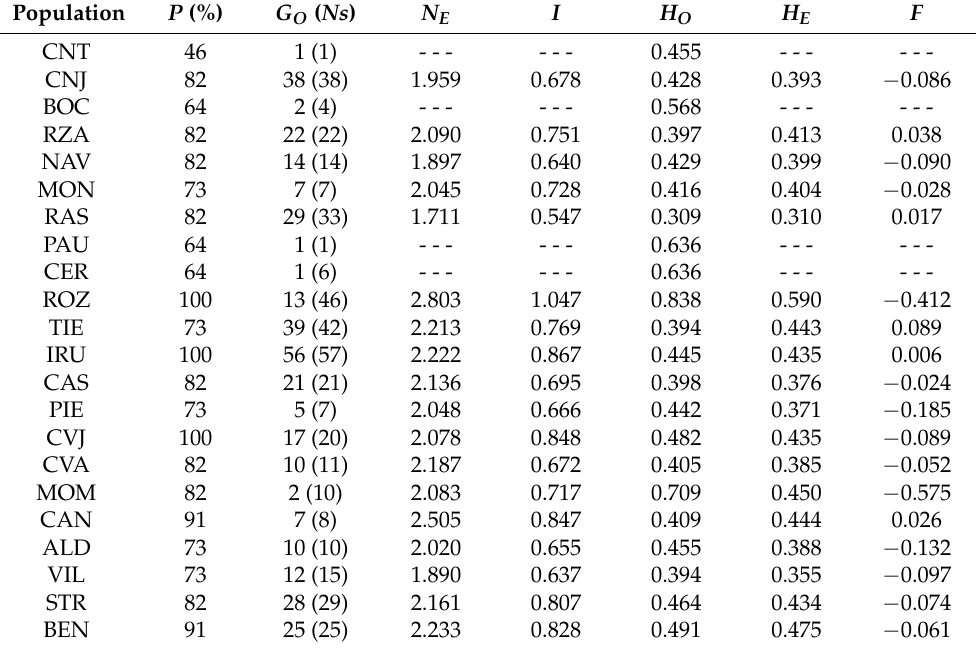
Table 3. Genetic diversity parameters calculated for Ulmus glabra populations from the Central System of the Iberian Peninsula using data from eleven microsatellite loci. See Table 1 for population